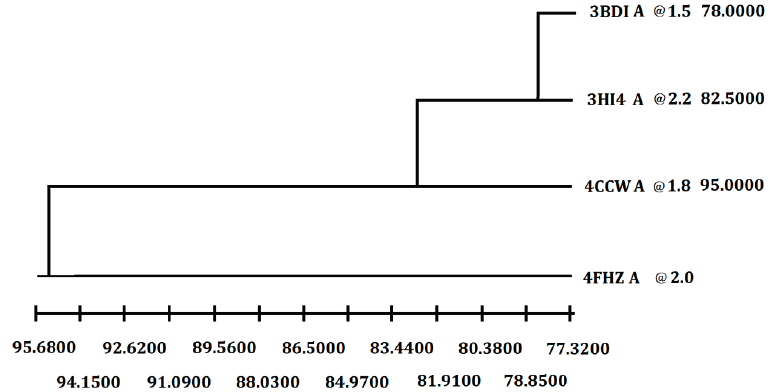
Figure 2. Selection of the best crystal structure template for homology modeling. Weighted pair-group average clustering based on a distance matrix. The last column represents the distance between this protein’s cluster and those below